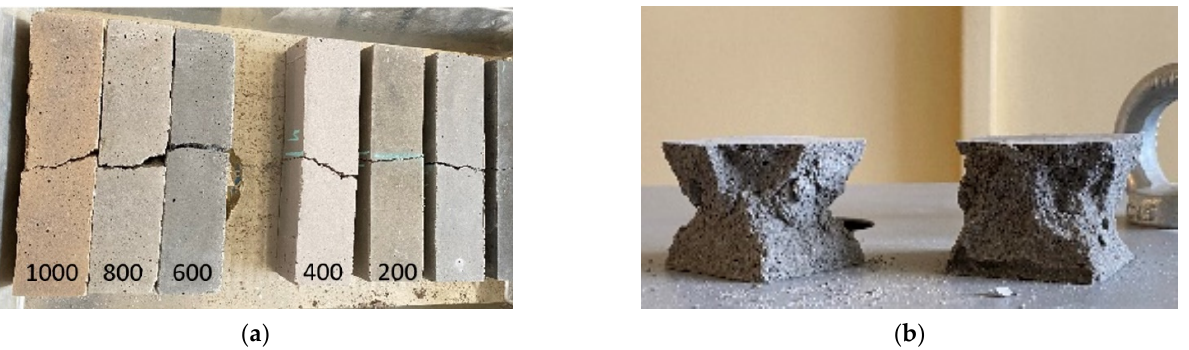
Figure 2. Samples after mechanical tests: ( a ) after bending tests, ( b ) after compressive tests.